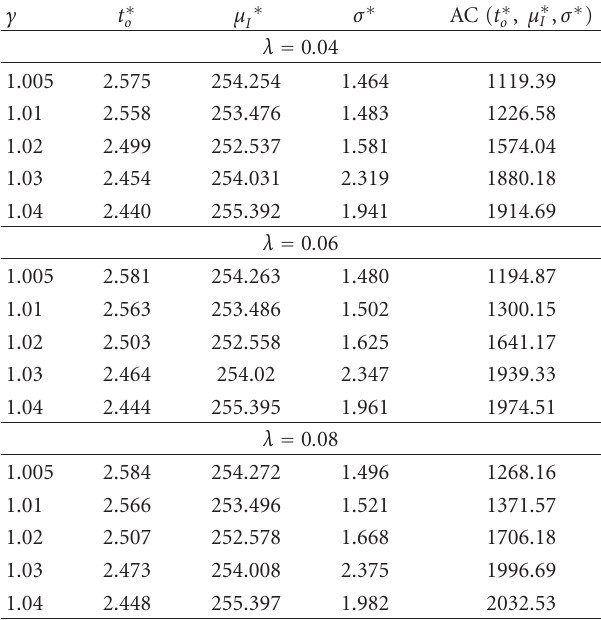
Table 2: Dependent of the optimal policy ( t ∗ ters λ and γ